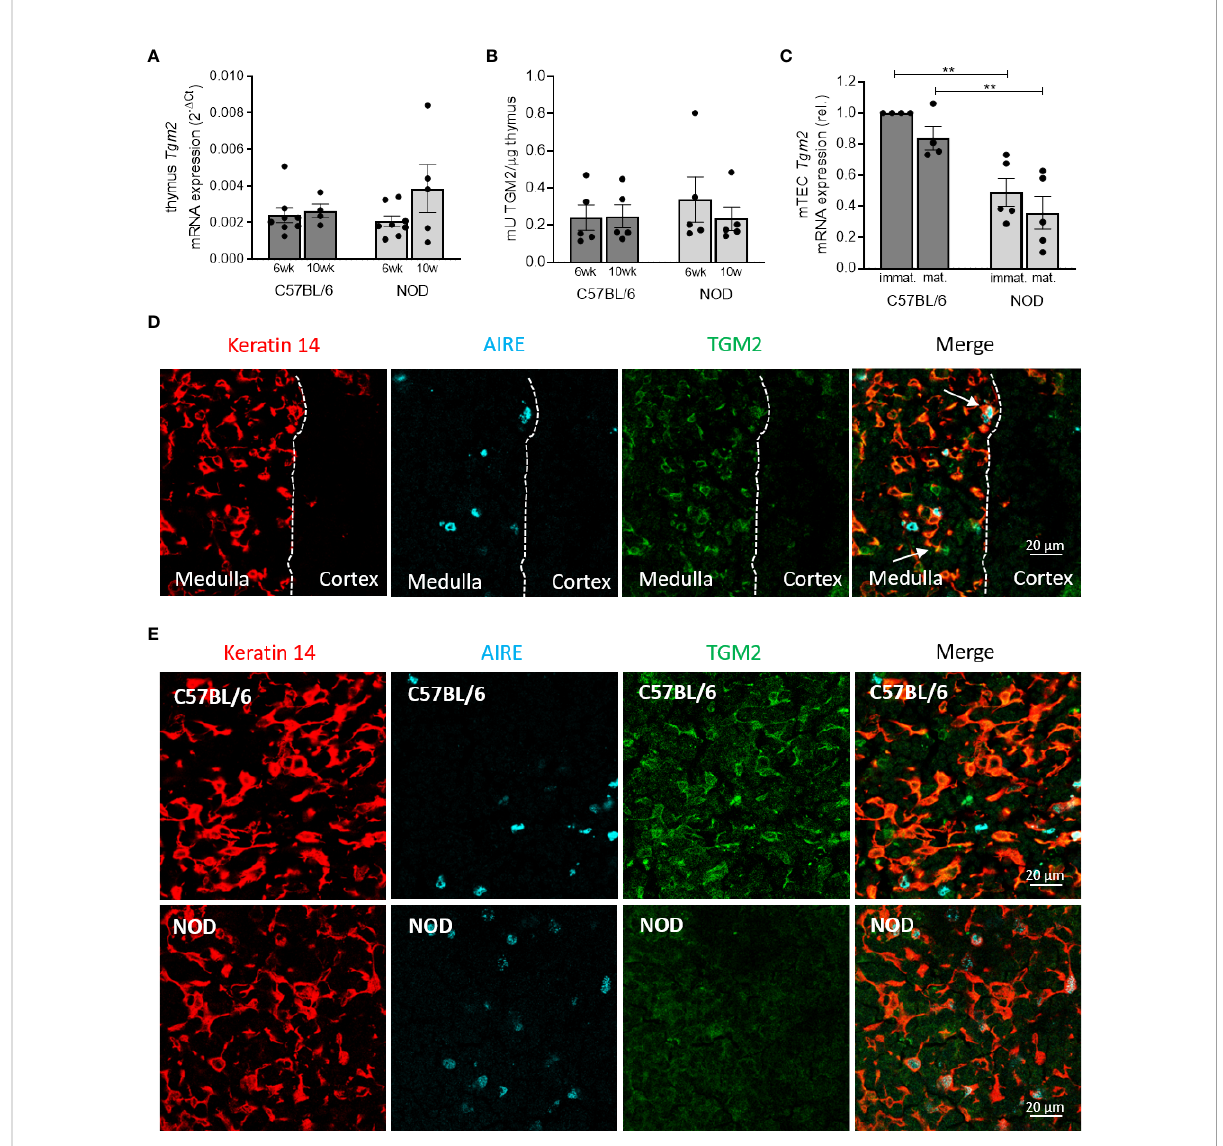
FIGURE 5 Deamidation is present in the thymus but TGM2 expression is reduced in mTECs of NOD mice. Tgm2 mRNA levels (A) and TGM2 activity (B) in the thymus of 6- and 10-week-old C57BL/6 and NOD mice. (C) Tgm2 mRNA levels in immature (MHC-II low ) and mature (MHC-II high ) mTEC cells of C57BL/6 and NOD mice. (D) TGM2 protein expression in medulla and cortex of frozen thymic tissue sections of C57BL/6 mice. mTECs are visualized by keratin 14 staining, mature mTECs by AIRE. Dashed line represents the border of medulla and cortex. TGM2 co-localization in immature (yellow) and mature (white) mTECs are indicated with arrows. (E) TGM2 protein expression in murine mTECs in frozen thymic tissue sections of C57BL/6 and NOD mice. mTECs are visualized by keratin 14 staining, mature mTECs by AIRE. Data are shown as mean with SEM. One-way ANOVA with correction for multiple testing,